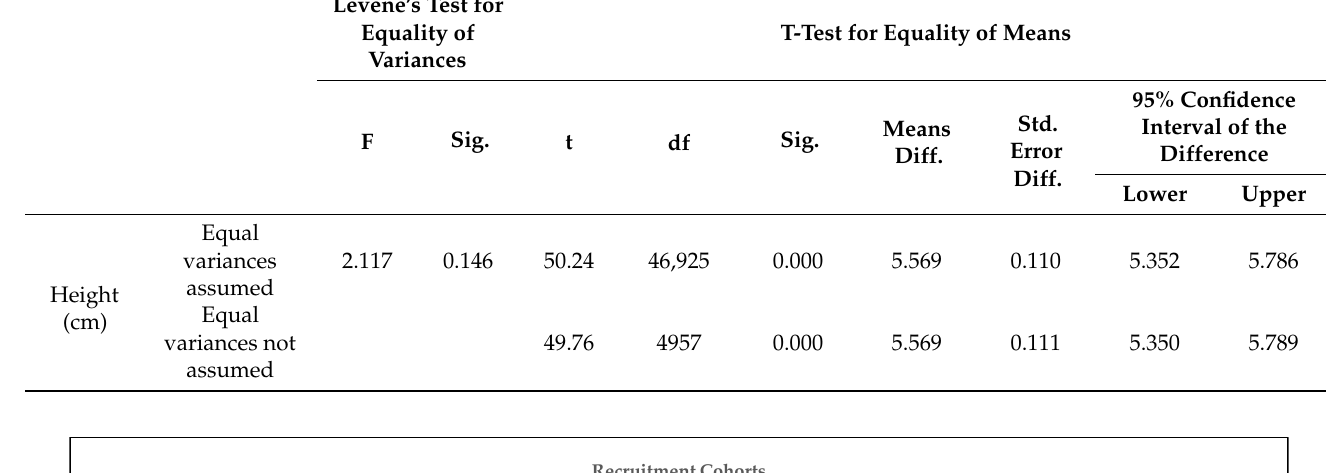
Table 4. T-test for equality of means in the sample Extremadura (students and non-students).